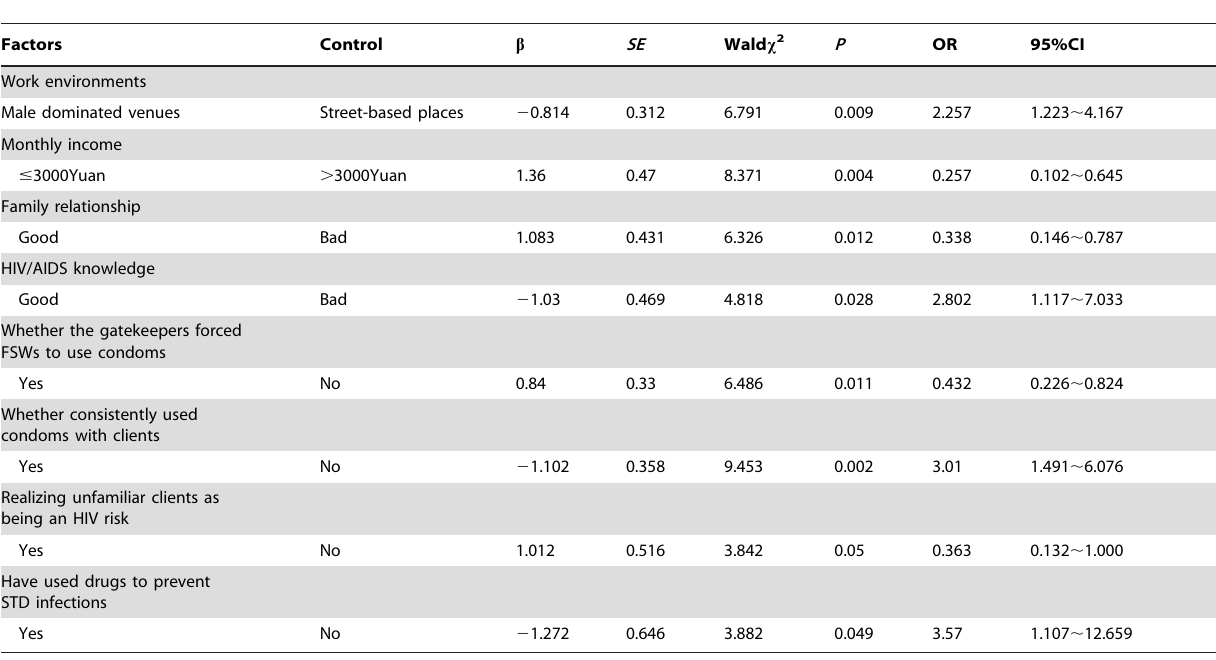
Table 4. Logistic regression analysis of willingness to use PrEP.